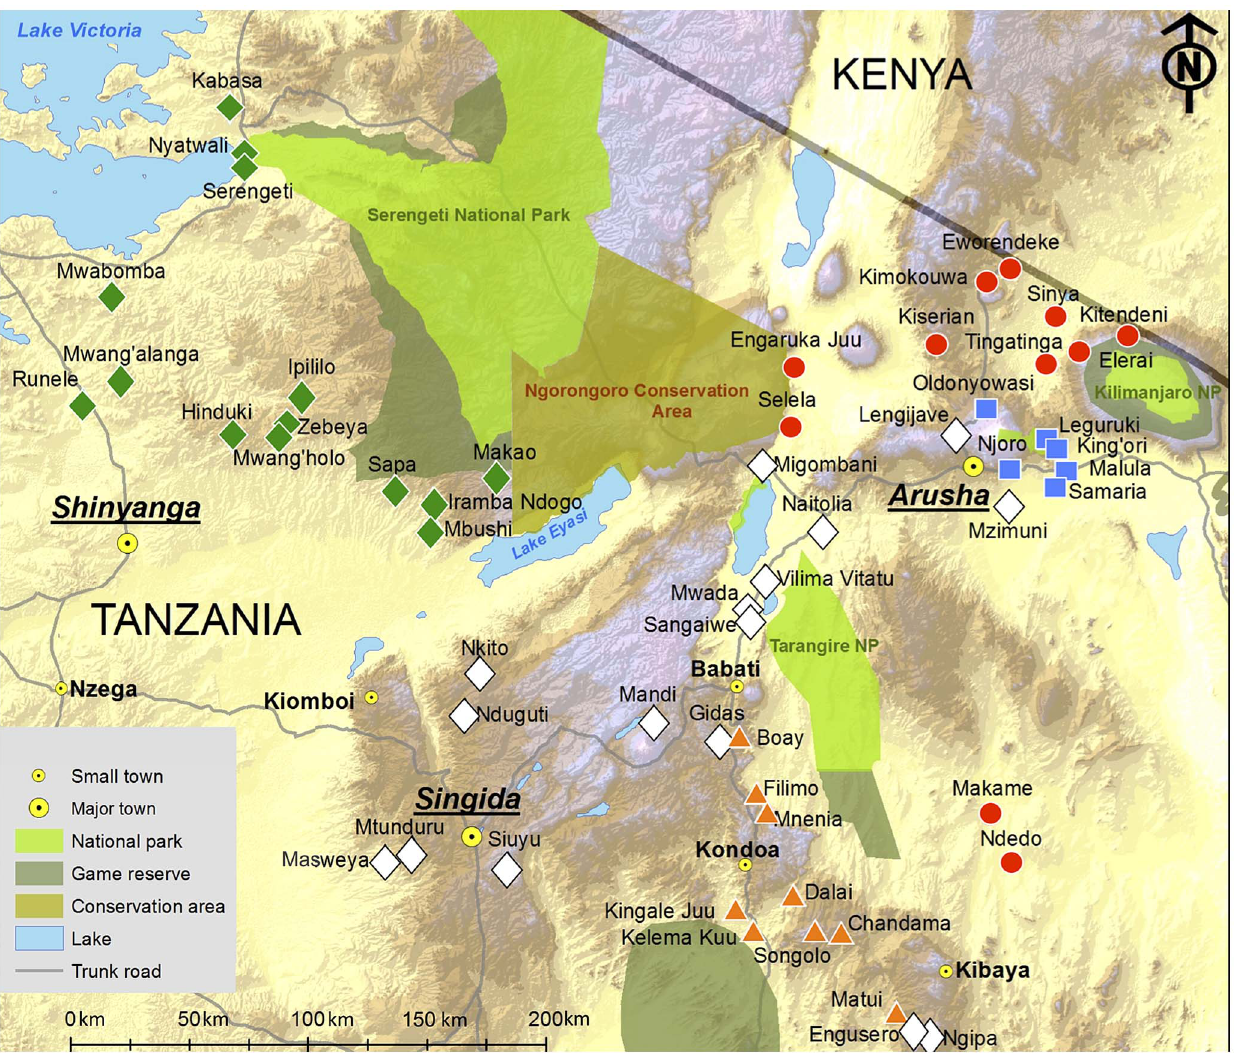
Figure1. Location of the 56 Study Villages Included in the Whole Village Project. Ethnicity is coded as the most common ethnicity in each village ( File S1 for details). Red circle = Maasai village; orange triangle = Rangi village; green diamond = Sukuma village; blue square = Meru village; white diamond = Other ethnicity village. Figure adapted from Aichele et al. [76] and initially published under an open-access license (CC-BY).